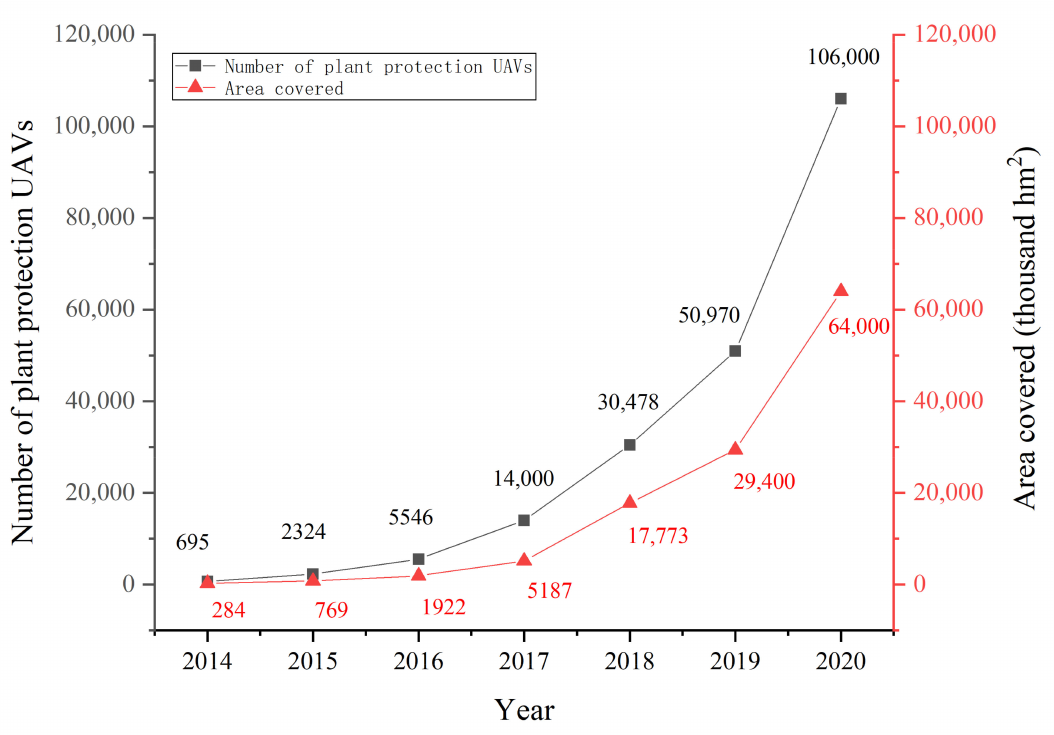
Figure 1. Increasing number of plant protection UAVs and operating area covered in China (2014–2020).